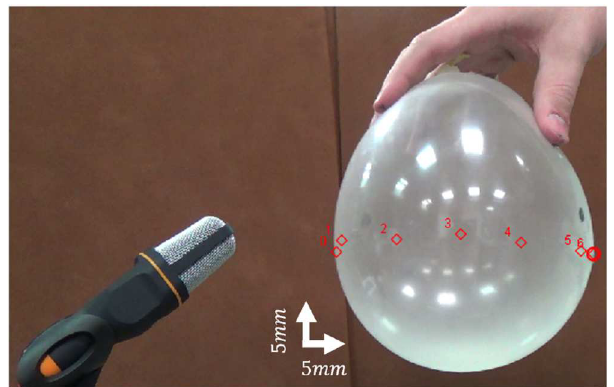
Fig. 2. Figure of the system analyzed via Tracker during our experiments. The distance between microphone and balloon was approximately the same for all experiments. The points show the trajectory of the hex nut while it passed in the frontal part of the balloon obtained using the Tracker software.